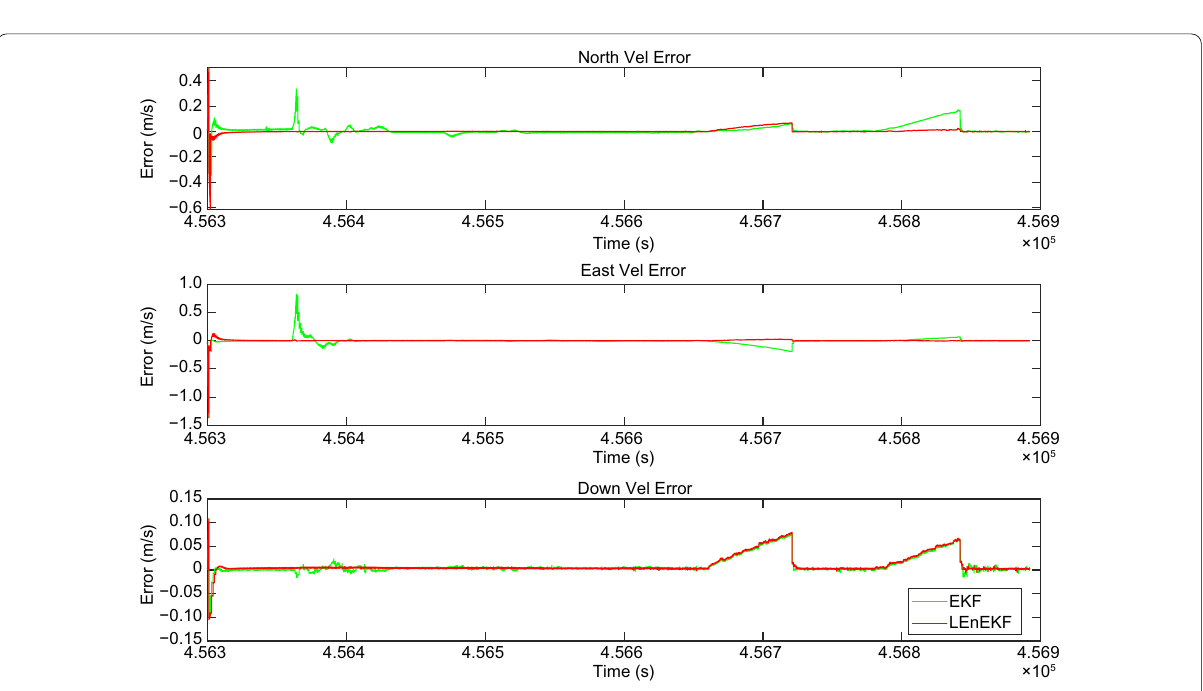
Fig. 6 Velocity errors of two 60 s GPS outages with large misalignment